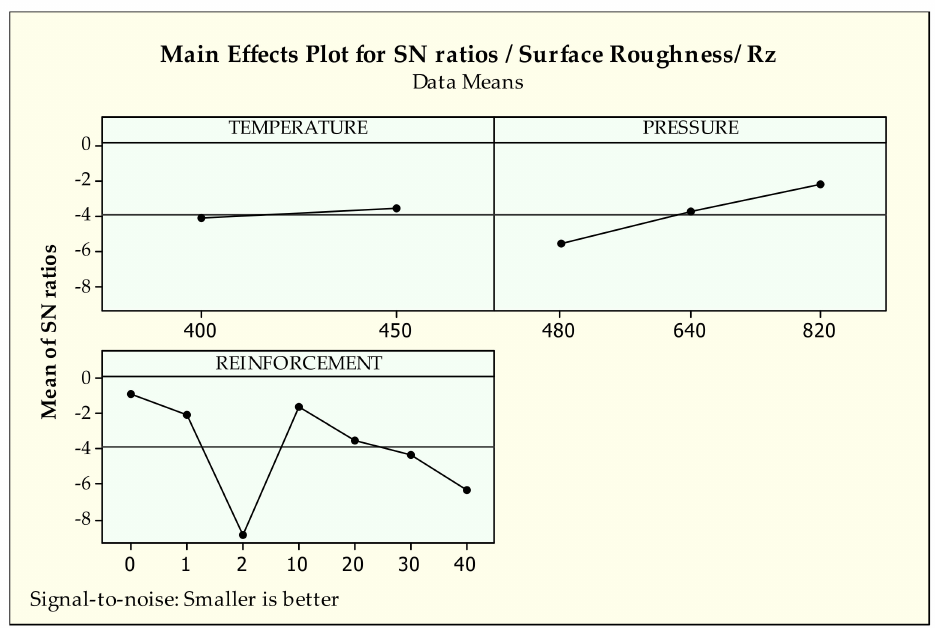
Figure 7. S/N ratios of surface